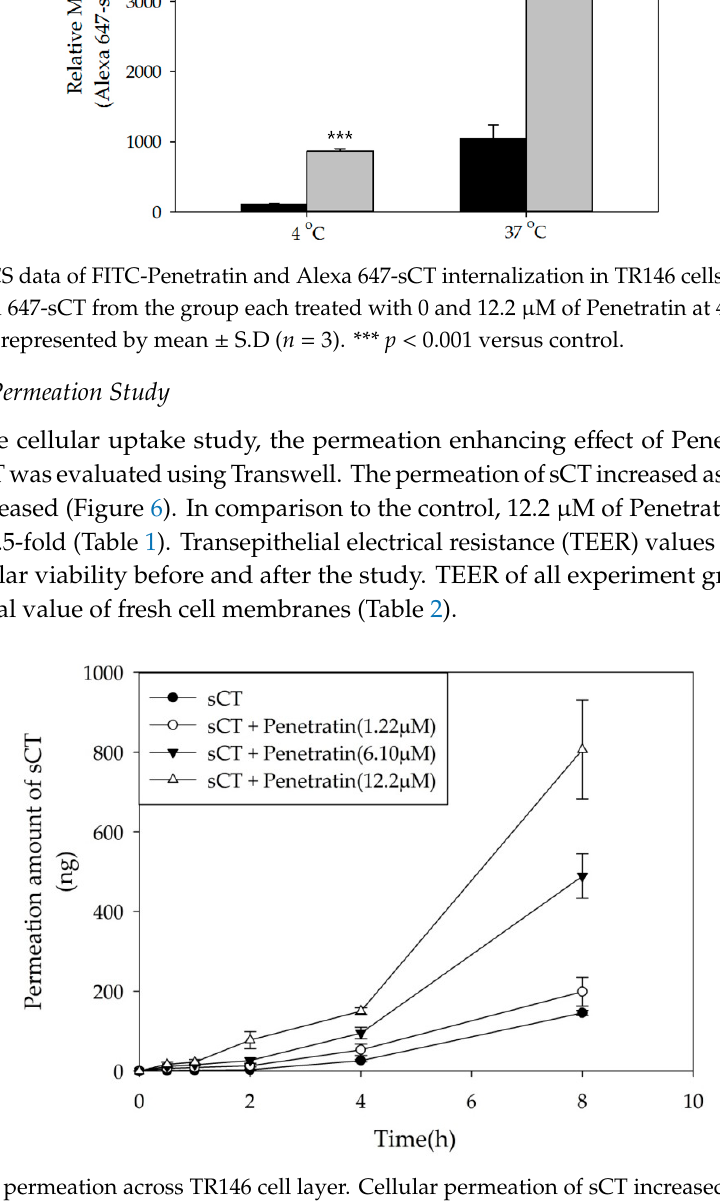
Figure 4. CLSM images of FITC-Penetratin and Alexa 647-sCT internalization in TR146 cells after 2 h of incubation at 37 °C. Notes: Blue: nuclei stained with DAPI; green: FITC-Penetratin; red: Aelxa 647- sCT, respectively.